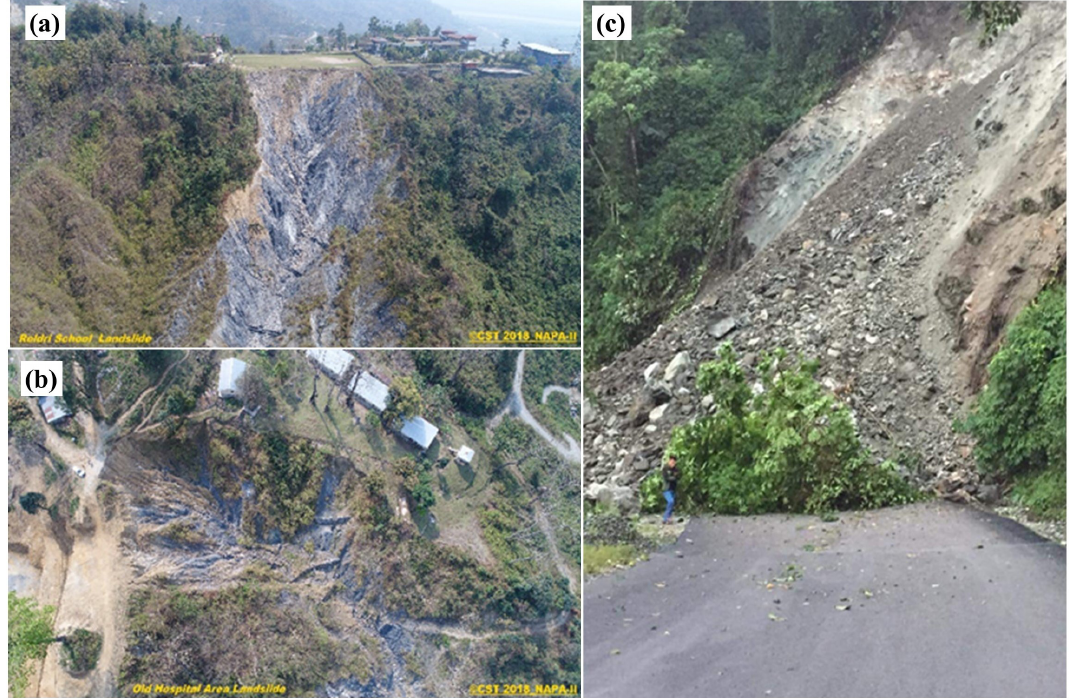
Figure 2. ( a , b ) Road and infrastructure affected by landslide at 5 km chainage, Rinchending and ( c ) Landslides roadblock at 17 km chainage, Sorchen, in the study area (photo courtesy: College of Science and